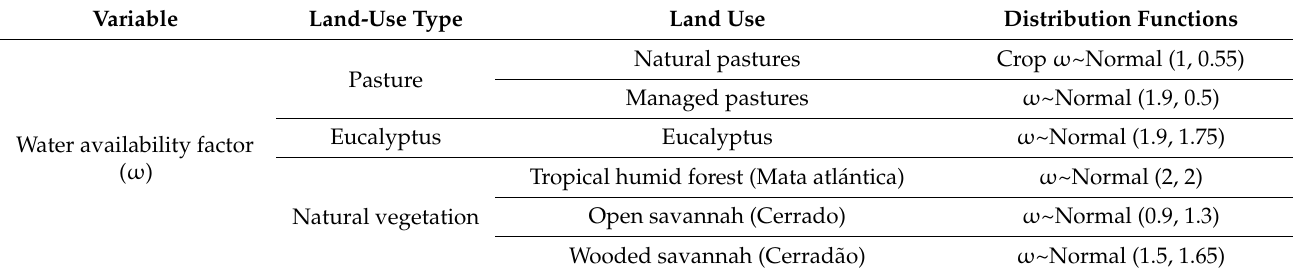
Table A1. Parameters used in the estimation of water consumption per land